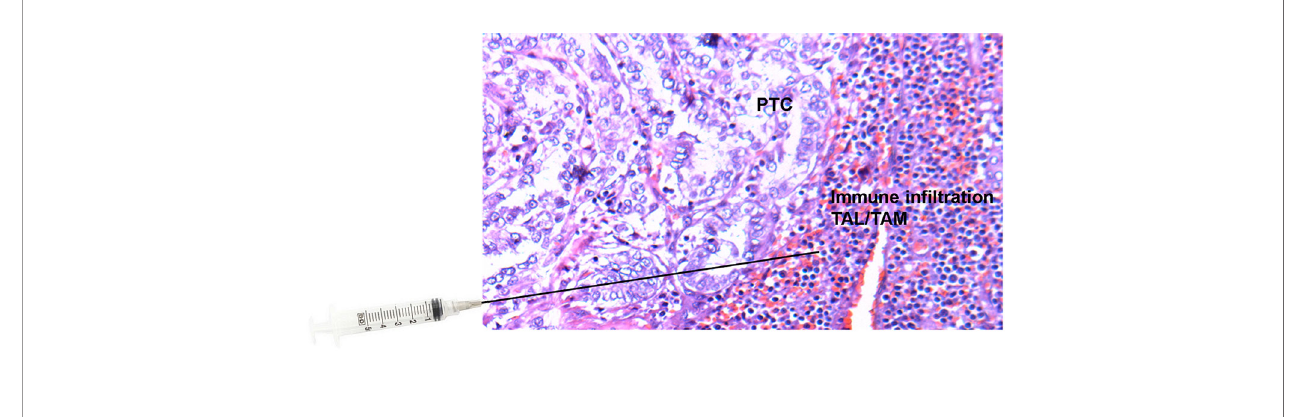
FIGURE 1 | Tissue slide of papillary thyroid cancer (PTC) with adjacent immune cell in fi ltration [tumor-associated lymphocytes (TALs) and macrophages (TAMs)] stained with Hematoxylin and Eosin (H&E) and superimposed needle illustrating the area within and adjacent to the thyroid nodule from which ultrasound-guided fi ne- needle aspirations (FNAs) were